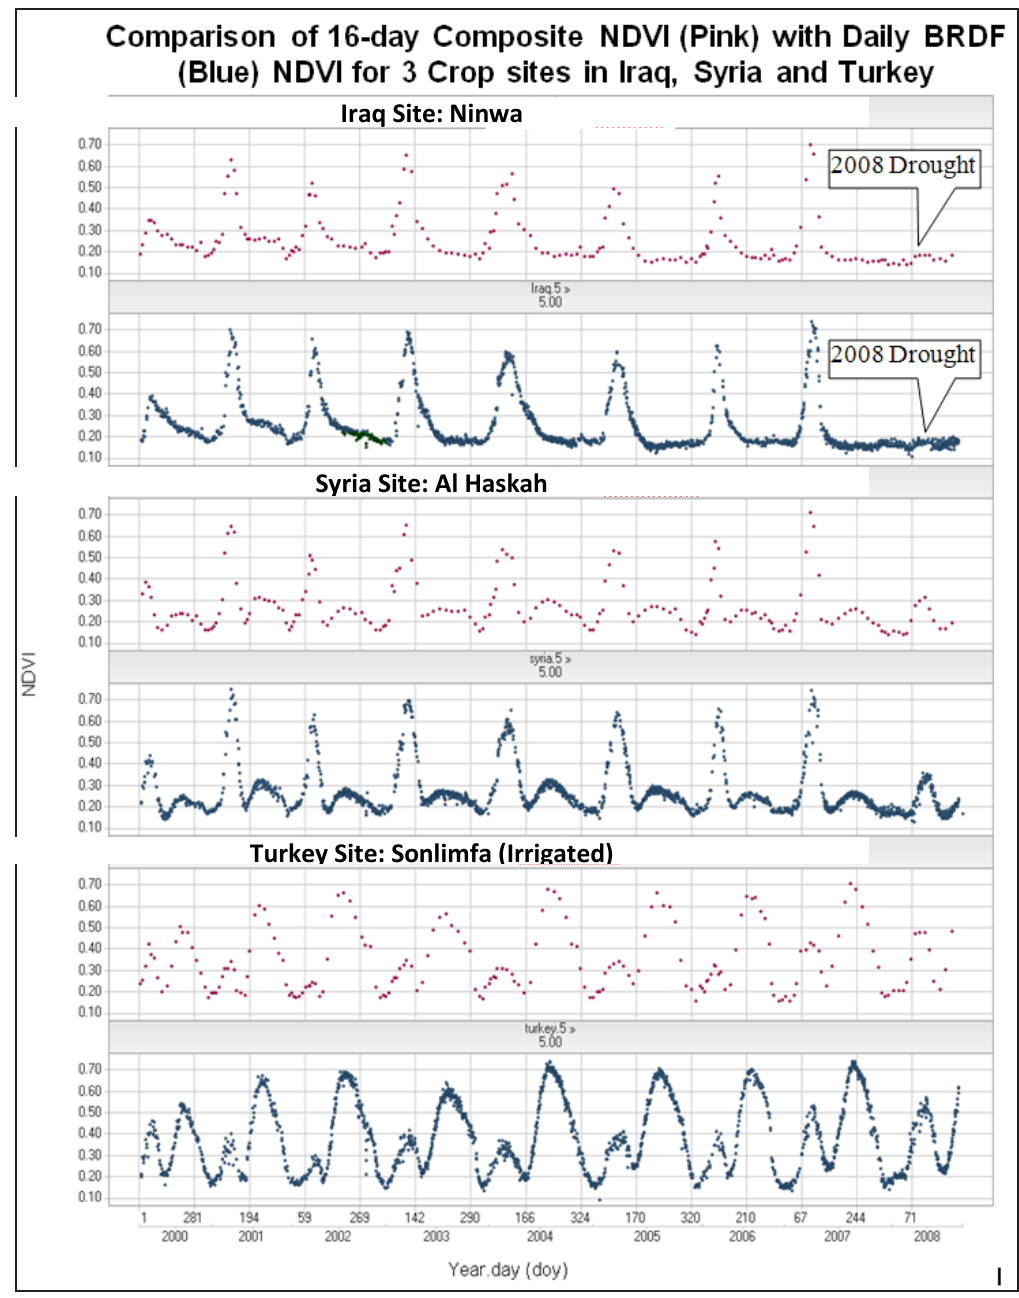
Figure 6. Comparison of 16-day Composite NDV (pink)I with Daily BRDF Corrected NDVI (blue) for 3 Crop sites in Iraq, Syria and Turkey. Both the pink and blue graphs show similar crop phenology though crop development is more clearly depicted in the blue, daily BRDF corrected